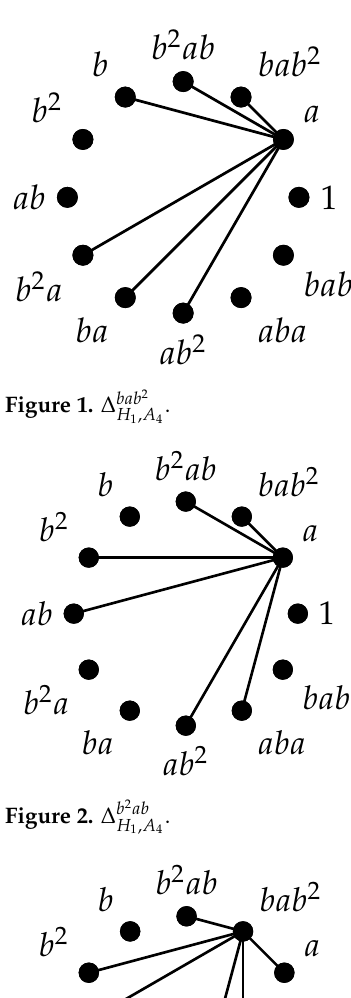
Figure 2. ∆ b Figure 3. ∆ a